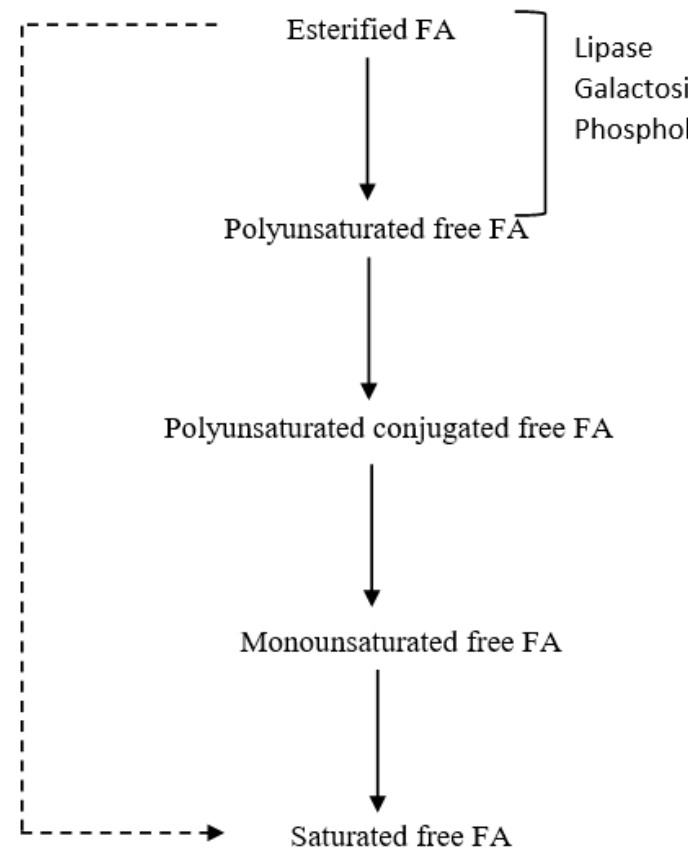
Figure 2. The scheme of lipolysis and biohydrogenation (adapted from Buccioni et al. [88]).